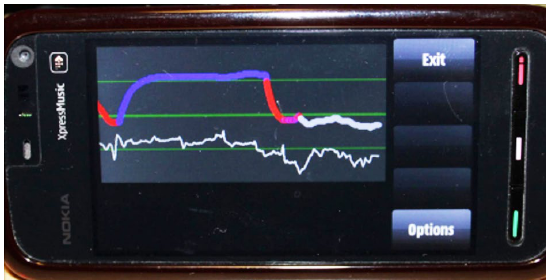
Fig. 5. Friction measurements on the screen of a mobile phone (Bulevičius et al.